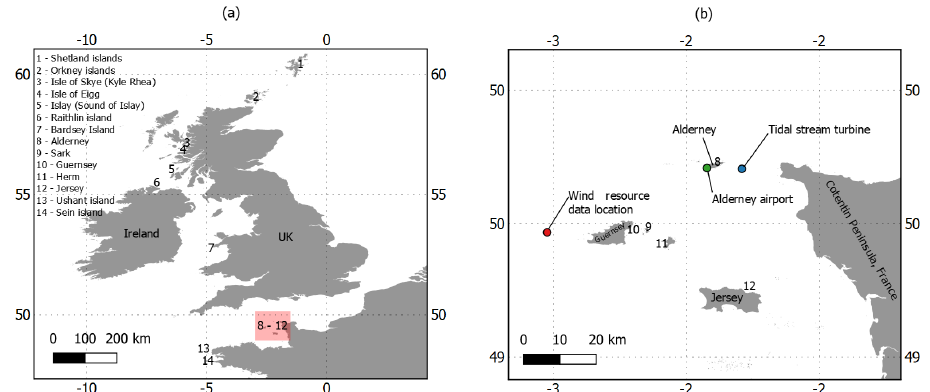
Figure 1. Location of ( a ) remote off-grid/grid constrained areas of high tidal stream energy resource in the UK and France, and ( b ) the location of Alderney in the Channel